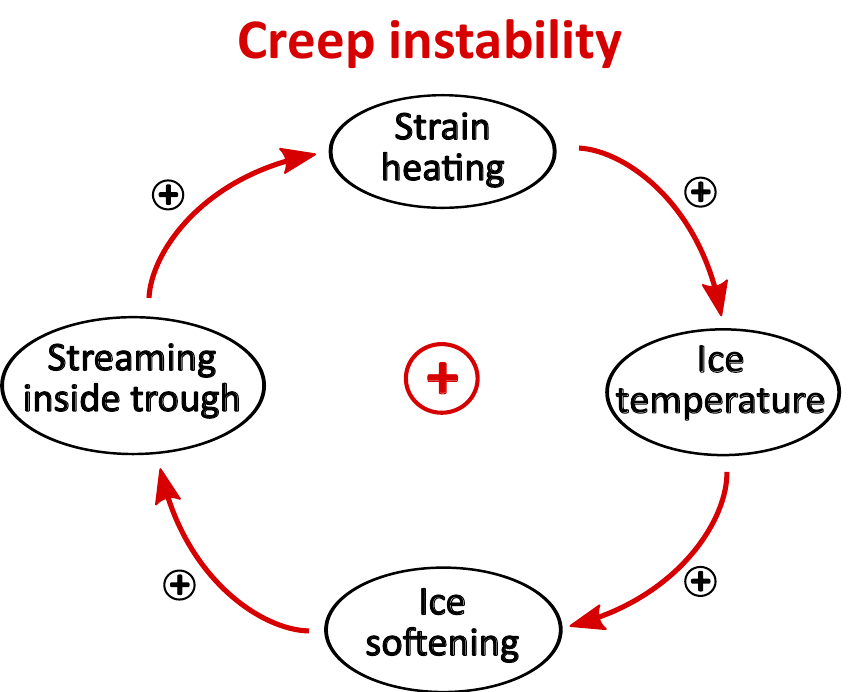
Figure 5. Positive feedback of creep instability, which fosters rapid ice streaming through the bed trough in addition to the positive feedback of ice-flow acceleration visualized in Fig.